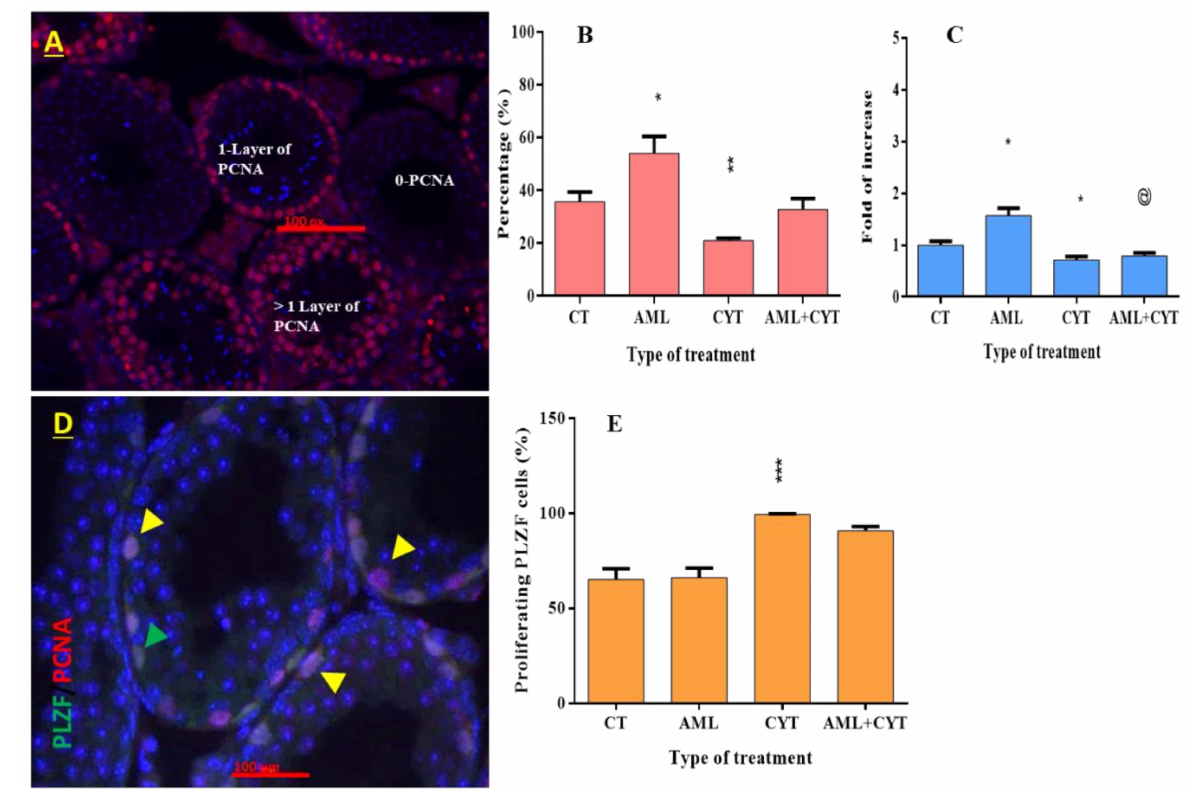
Figure 6. Effect of AML and CYT on testicular cell proliferation and cell proliferation of premeiotic cells in testicular tissue of immature treated mice. Mice and testes were treated as described in Figure 1. Fixed testicular tissues were immunoassayed with specific anti-PCNA antibodies to identify the proliferating cells and anti-PLZF antibodies to identify the premeiotic cells. Tubules with PCNA- positive cells are presented as % of tubules with one layer of PCNA-positive cells. Immunostaining ( A ) and quantification of the staining ( B ). The RNA expression levels of PCNA in the testes isolated from each treatment group were examined by qPCR analysis using specific primers ( C ), and house- keeping gene (GAPDH) was used as internal control. The results are presented as fold of increase com- pared to GAPDH. Testicular tissues were immunoassayed with specific anti-PLZF and anti-PCNA an- tibodies to identify the proliferating premeiotic cells. Tubules with doubled positive cells are presented as % of proliferating PLZF cells. Immunostaining ( D ) and quantification of the staining ( E ). N = 3; n = 5–7/group; #tubules/group = 40–110; n = 5–7/group (RNA expression). * ( p < 0.05), ** ( p < 0.01), *** ( p < 0.001) significant relative to control group. @ ( p < 0.05) significant relative to AML group. Green arrow indicates PLZF-positive stained cells. Yellow arrow indicates proliferating PLZF-positive stained